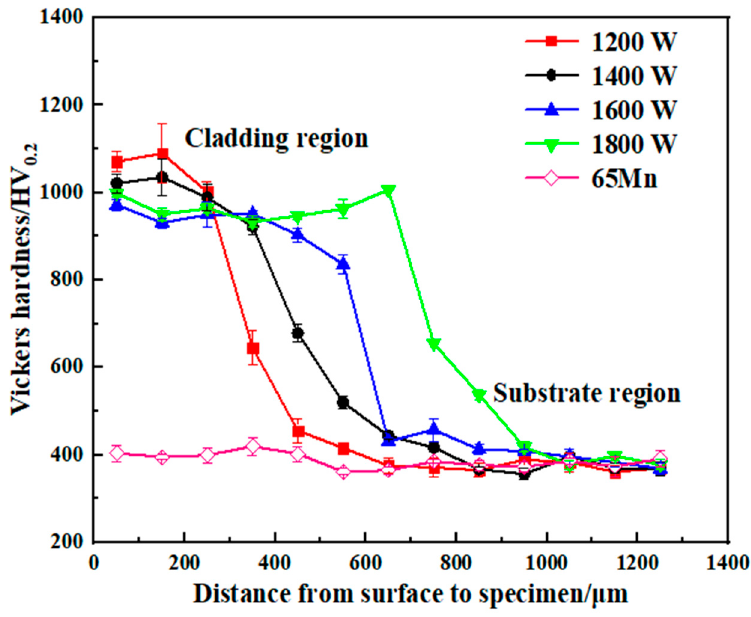
Figure 9. Microhardness distribution curve of the cladding layer at different laser powers (65 Mn steel substrate).